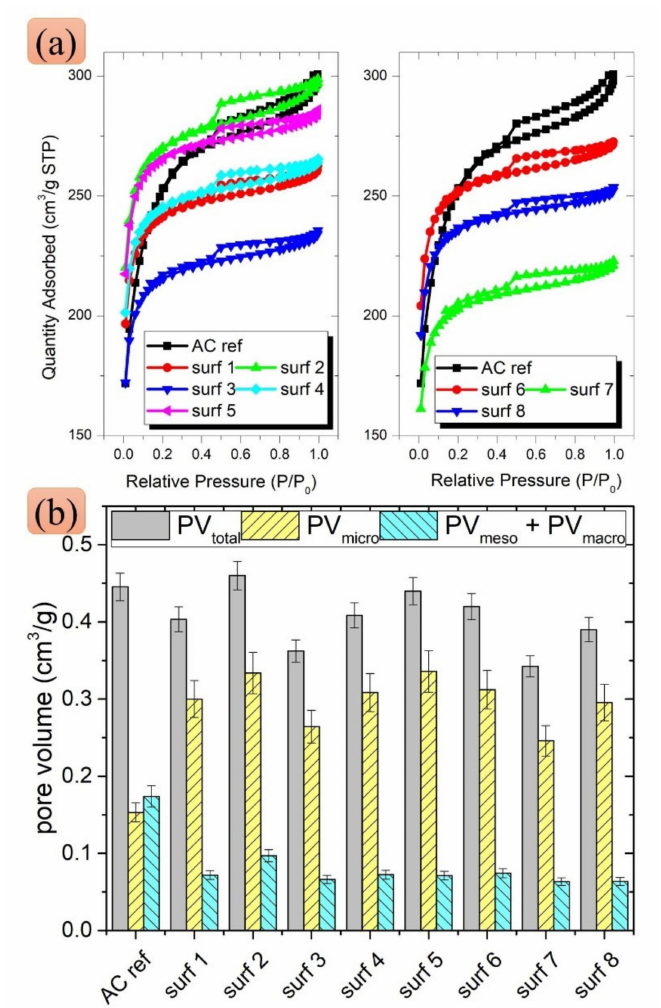
Figure 2. ( a ) N 2 adsorption–desorption isotherms at 77 K and ( b ) total pore volume (PV tot ), PV micro , and PV meso + PV macro of raw and surfactant-modified